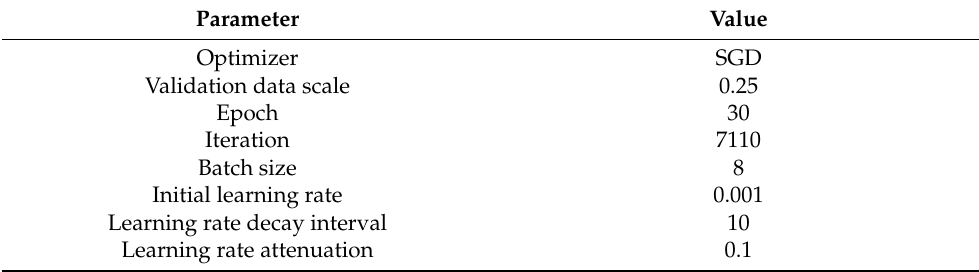
Table 1. Experimental parameter settings of the network model. Parameter Value Optimizer SGD Validation data scale 0.25